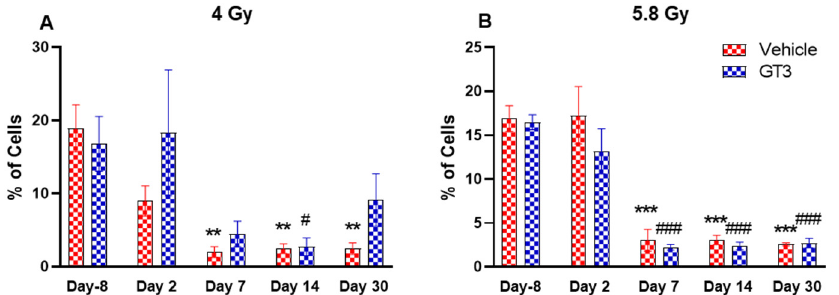
Figure 6. Effects of 4 Gy ( A ) and 5.8 Gy ( B ) on B cell expression in BM of NHPs. NHPs received GT3 (37.5 mg/kg) or vehicle 24 h prior to irradiation (4 and 5.8 Gy). BM was collected at various time points and expression of B + cells were analyzed. Data are expressed as mean ± SEM. ** p < 0.01, *** p < 0.001 vs. vehicle day-8; # p < 0.05, ### p < 0.001 vs. GT3 day-8.